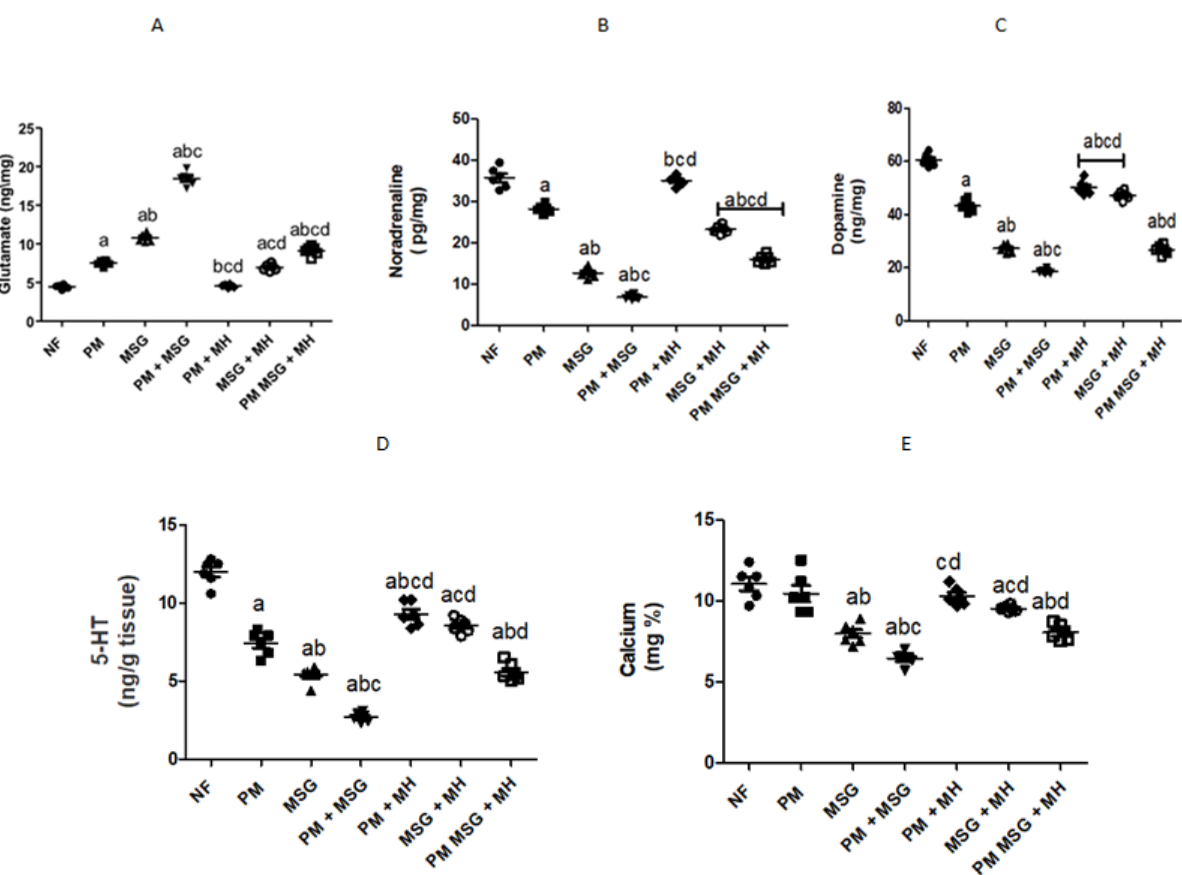
Figure 6. MH balances monoamines neurotransmitters of PM and/or MSG—fed rat pups. Effect of MH (60 mg/kg) on brain inflammatory biomarkers contents: ( A ) glutamate; ( B ) dopamine; ( C ) nor- adrenalin; ( D ) 5-HT; and ( E ) calcium levels using ELISA technique on low protein diet and/or 0.4 g/kg MSG. Data presented as mean ± SEM ( n = 6). a–d depicts significant difference regarding NF, PM, MSG, PM + MSG groups, respectively, at p < 0.05. Statistical analysis was performed using one- way ANOVA followed by Tukey’s post hoc test. [The data of the effect of MH on the control NF is